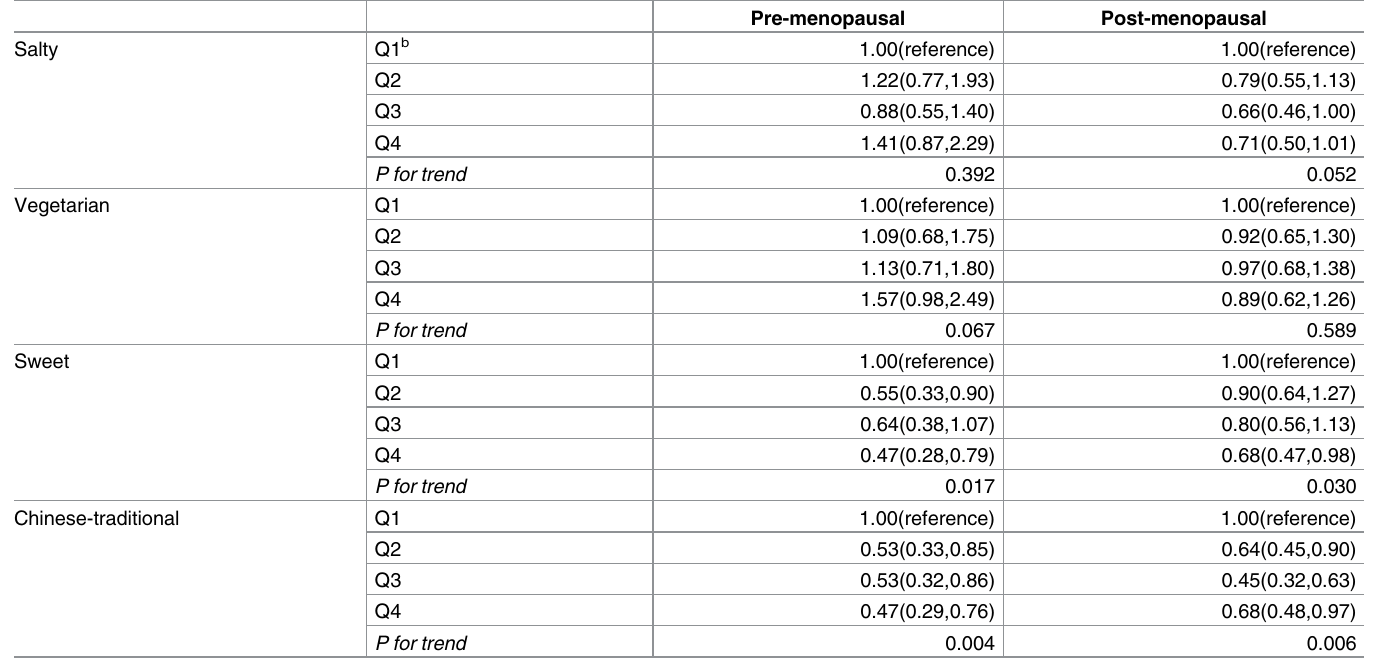
Table 4. Odds ratio (OR) and 95% confidence interval (95% CI) of breast cancer across quartiles of four dietary patterns by menopausal status a